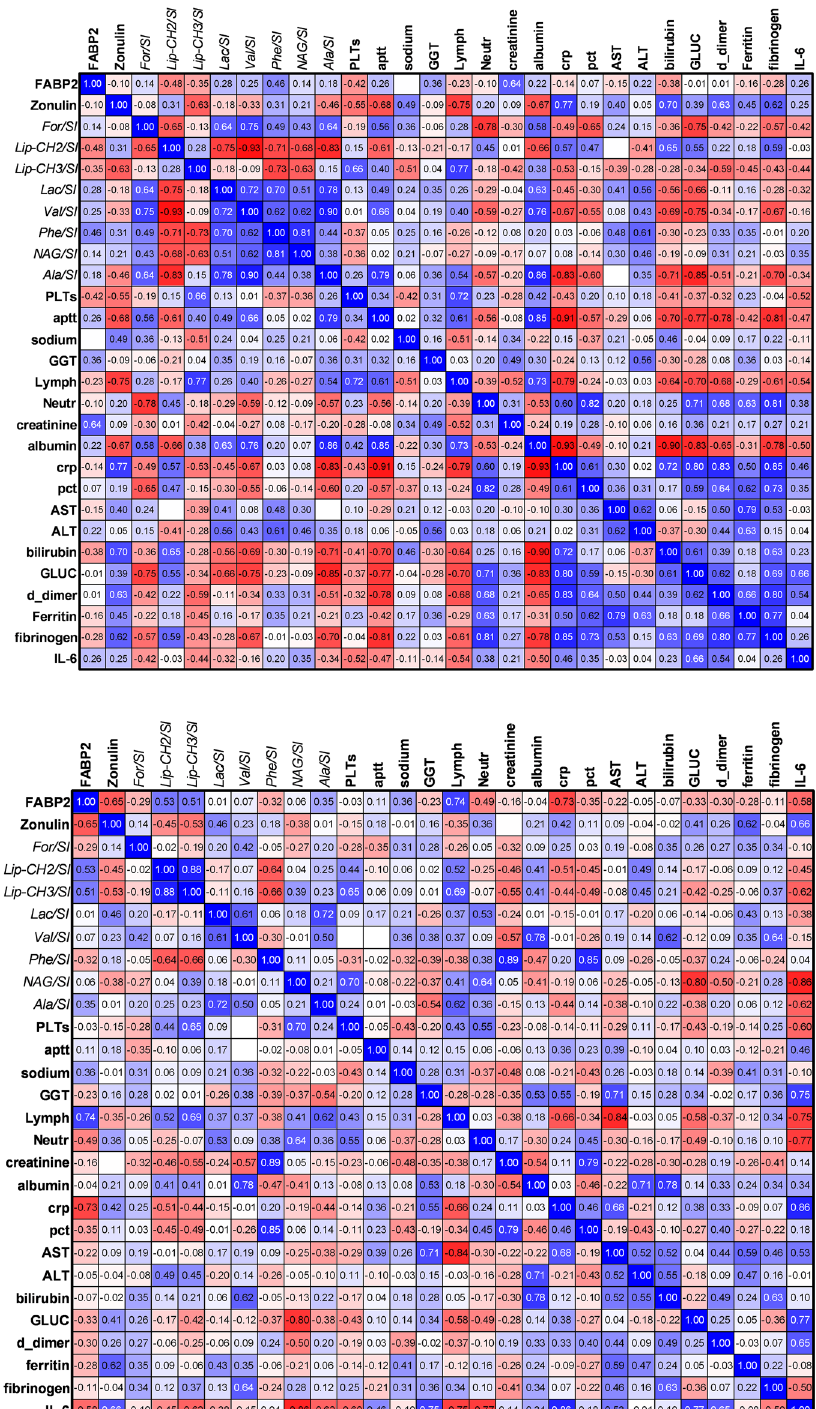
Figure 3. ( A ) Correlation Pearson R matrix showing association between gut biomarkers and plasma NMR metabolites for the milder group ( N = 15), after two outliers were removed, as determined by ROUT (ID 503, 291). ( B ) Associations between gut biomarkers and plasma NMR metabolites for the more severe group ( N = 13), after two outliers were removed, as determined by ROUT analysis (ID 506, 562). Blue indicates a positive association, red indicates a negative association. Stronger associations indicated by deeper